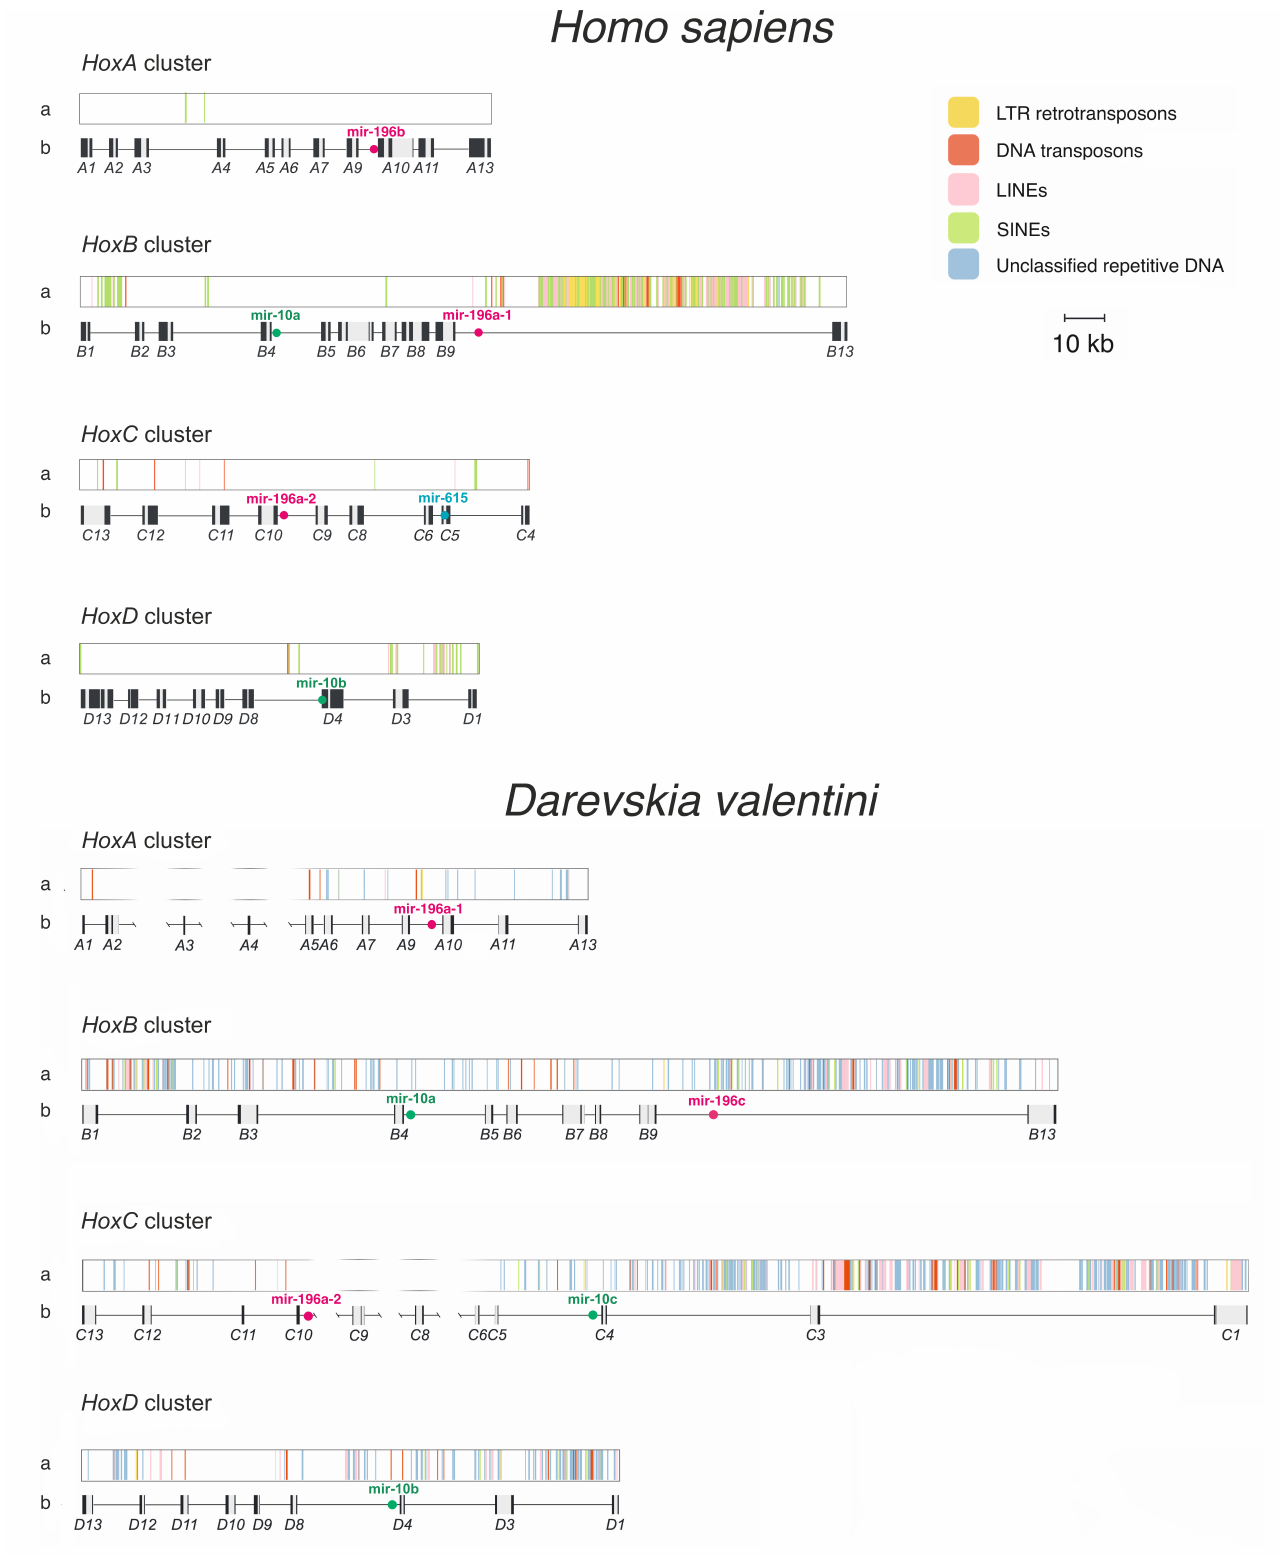
Figure 3. Comparison of Hox gene clusters (A–D) in Darevskia valentini and human genomes. ( a ) Mobile elements within each of the clusters: yellow—LTR retrotransposons, red—DNA trans- posons, pink—LINEs, green—SINEs, blue—unclassified repeat type. ( b ) Hox genes (grey—introns, black—exons) and miRNA genes. For several human genes, only coding DNA sequences (CDS) are